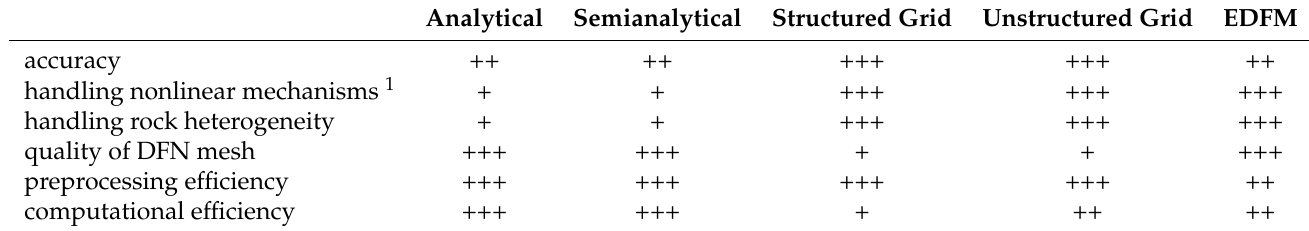
Table 1. Comparison of methods for the prediction of gas transport in unconventional reservoirs; 1 : nonlinear gas transport and storage, multiphase and multicomponent flow. DFN—Discrete Fracture Networks, EDFM—Embedded Discrete Fracture Model. Analytical Semianalytical Structured Grid Unstructured Grid